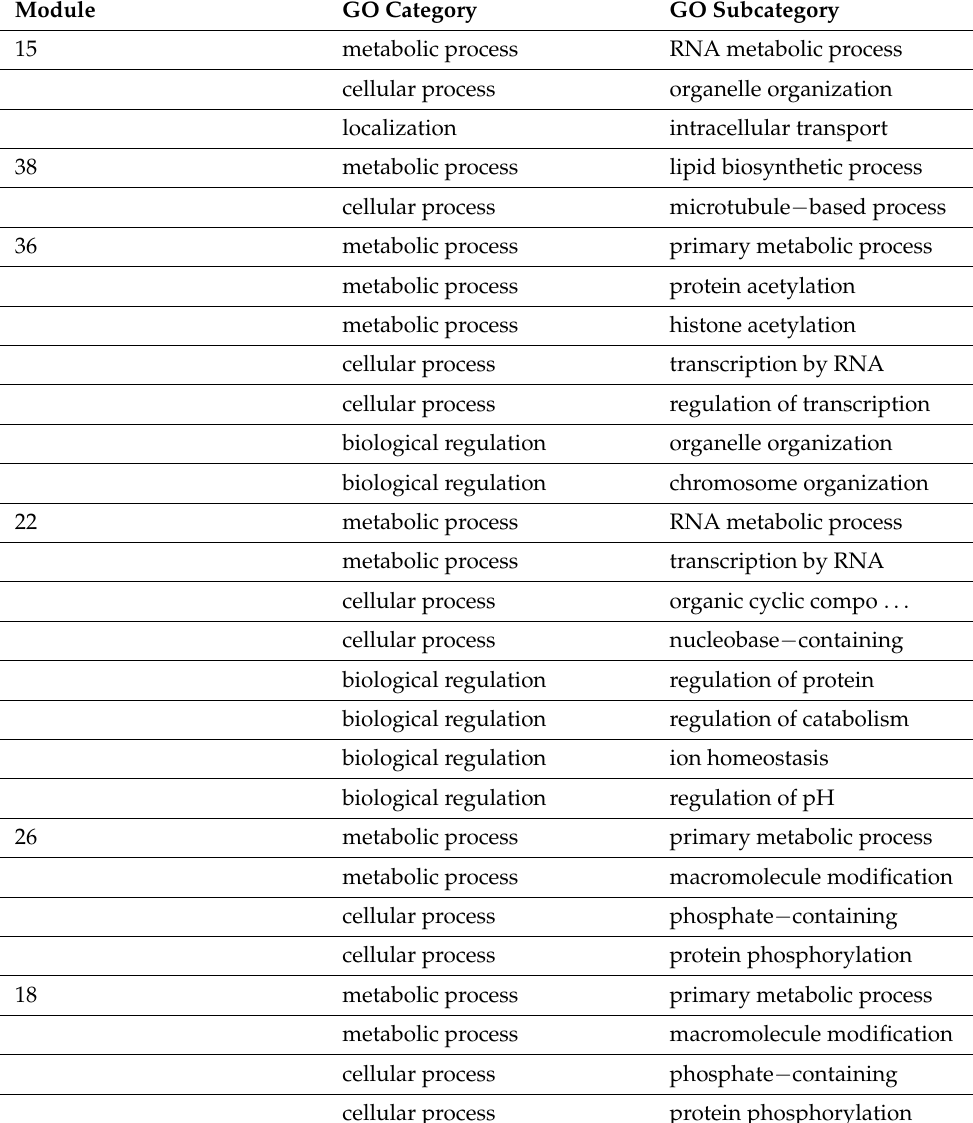
Table 4. The predominant annotated biological process categories and subcategories in the six selected